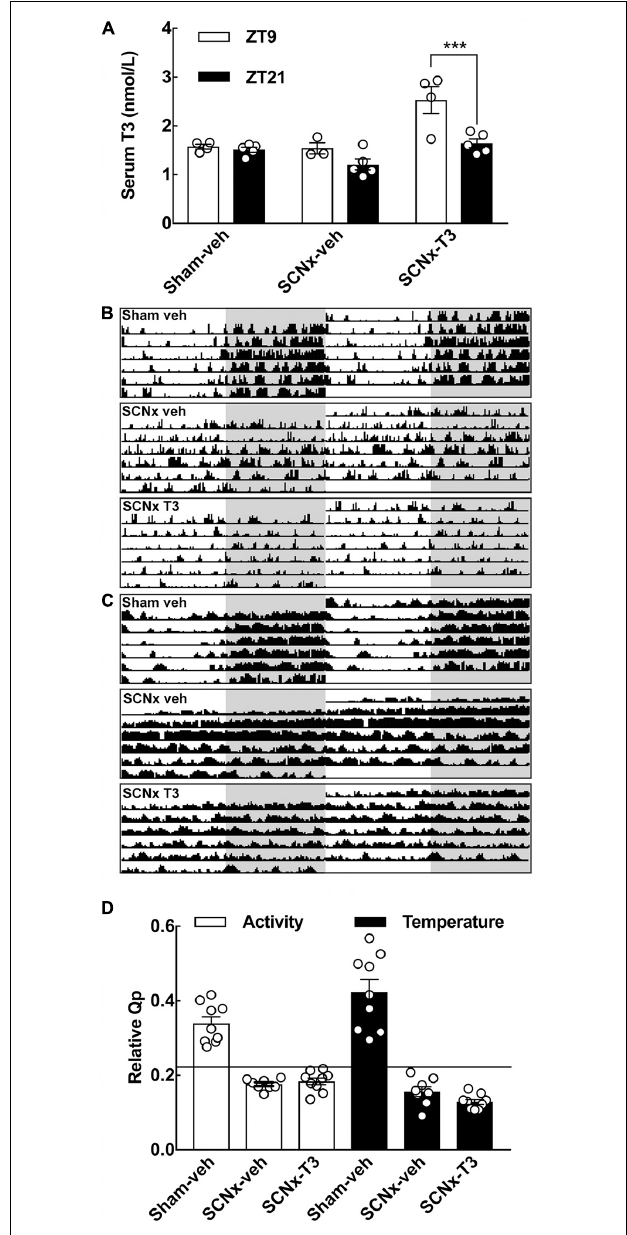
FIGURE 4 | Effects of SCN-lesions and circadian oscillating T3 infusion on T3 serum concentrations, locomotion and body temperature. (A) Serum T3 concentrations determined from the three experimental groups of adult rats (8 weeks of age), sham-veh, SCNx-veh, and SCNx T3 at ZT9 and ZT21, respectively. Data were analyzed by two-way ANOVA followed by Bonferroni multiple-comparisons tests. A significant rhythm in serum T3 is detectable in SCNx-T3. *** p < 0.001. n = 3–5. (B) Representative double-plotted actograms of locomotor activity from each experimental group. Locomotor activity values within the range 0–25 cm/min are displayed. Shaded areas indicate the 12 h of darkness. (C) Representative double-plotted actograms of body temperature from each experimental group. Temperature values within the range 36–38 ◦ C are displayed. Shaded areas indicate the 12 h of darkness. (D) Rhythm robustness on the y -axis expressed as a relative Qp -value for activity (left) and temperature (right). Horizontal line depicts a significance level of p = 0.05. n =